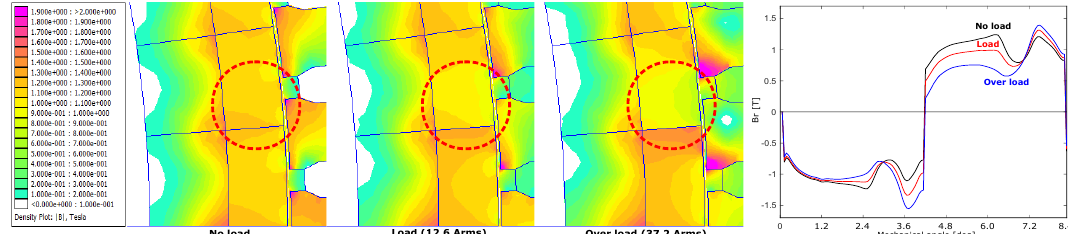
Figure 14. Demagnetization analysis of the reference